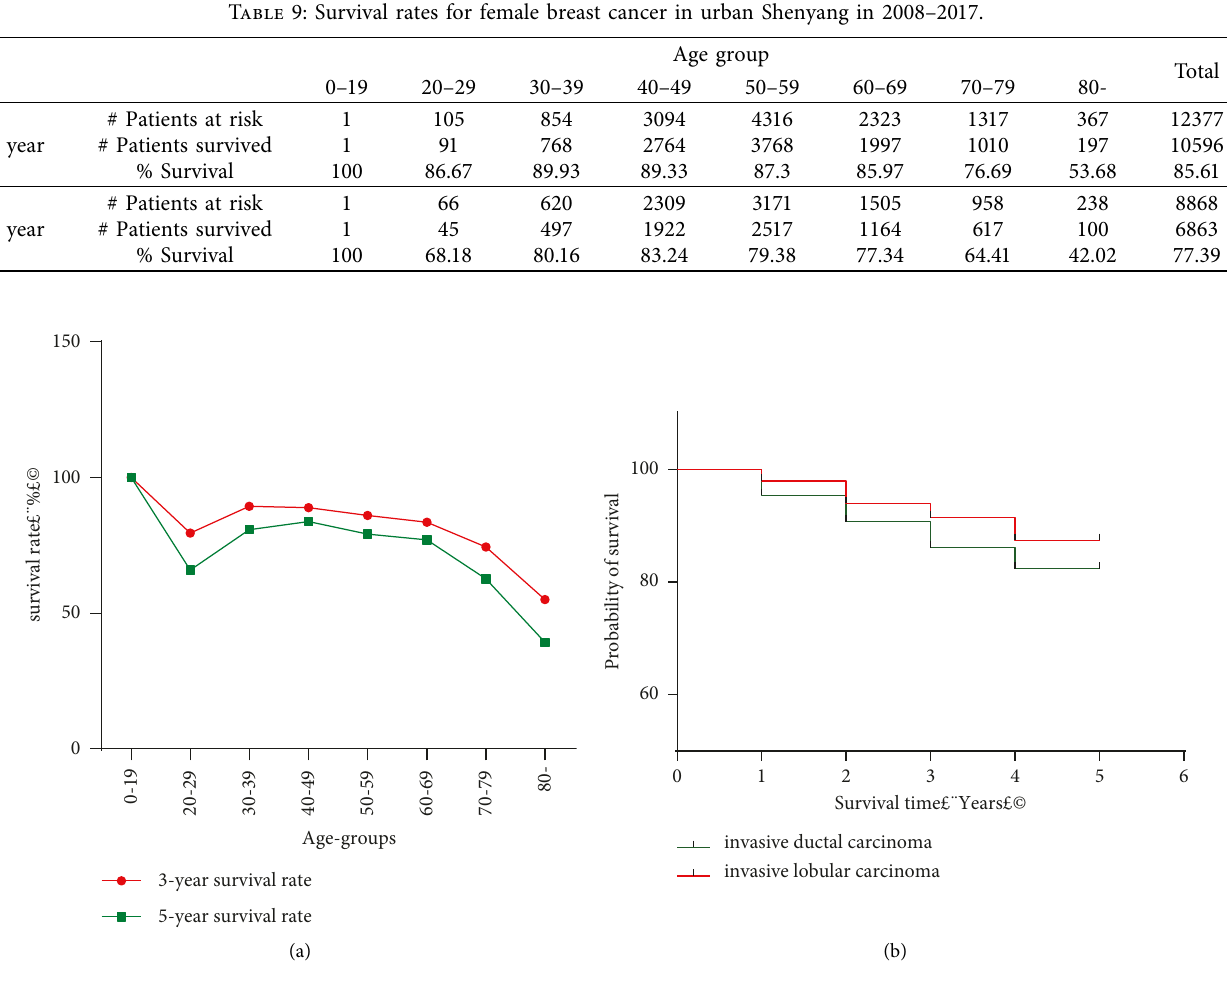
Figure 3: (a)The 3-year and 5-year survival rates for female breast cancer in urban Shenyang in 2008–2017. (b)The 3-year and 5-year survival rates of two common breast cancer histological types in urban Shenyang from 2008 to 2013 (the log-rank test p �